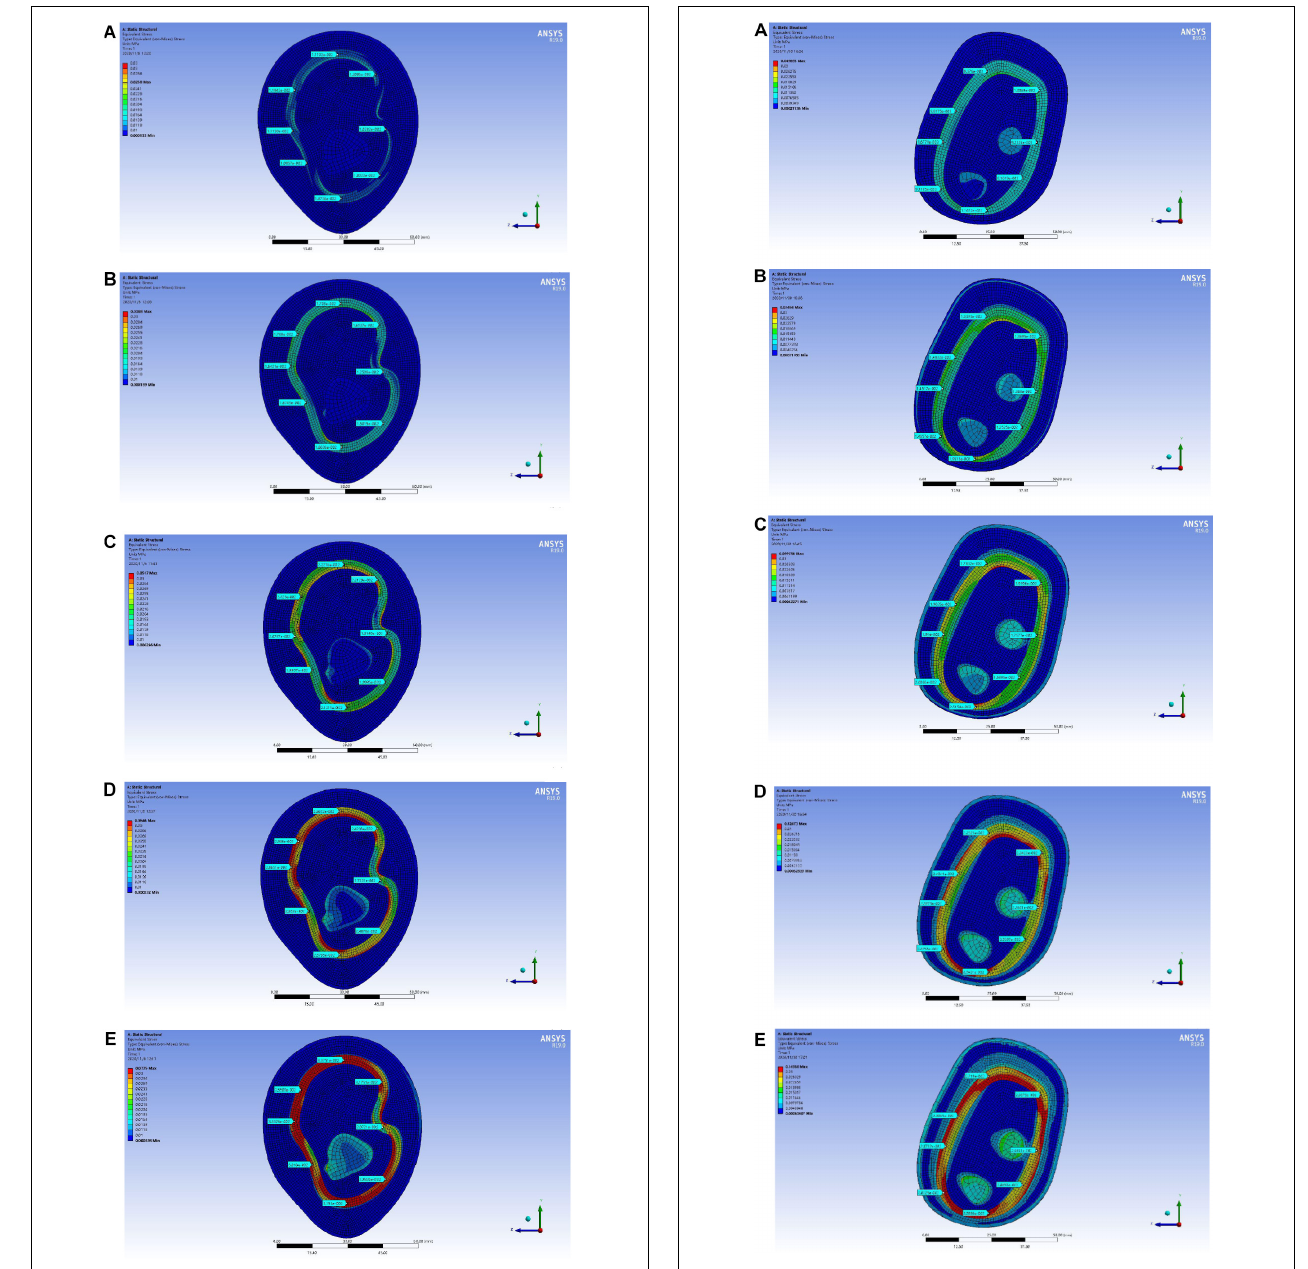
with different external force pressures are obtained, as shown in Table 4 . The eight point pressure tables of the lymph and the blood layers of the forearm model with different external force pressures are obtained, as shown in Table 5 . The data obtained by ANSYS software are sorted out and analyzed. In the upper arm model and the forearm model,